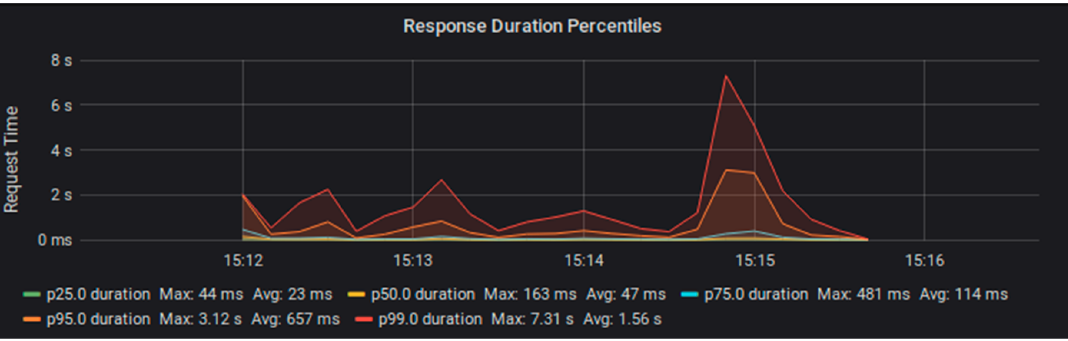
Figure 9. Trellis Cassandra (four and four) response duration percentiles at 480 RPS.